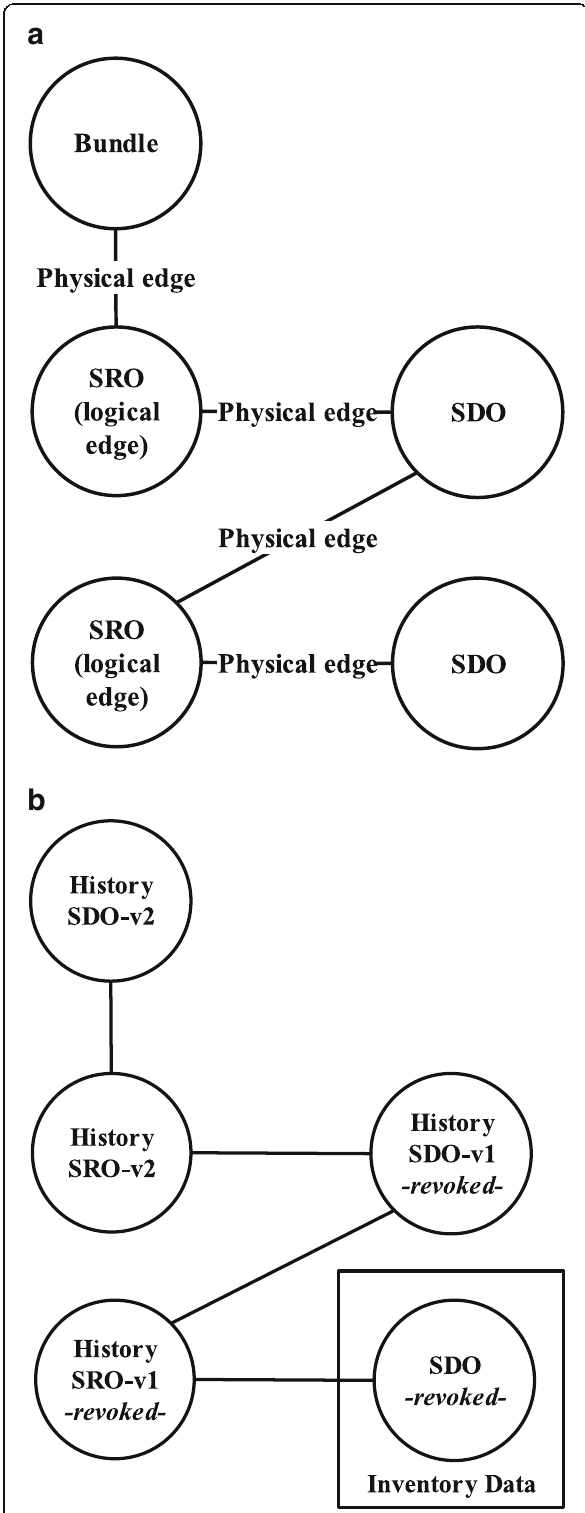
Fig. 1 CTI Vault of KAVAS. a Persisted Inventory Data ( b ) Enriched Inventory